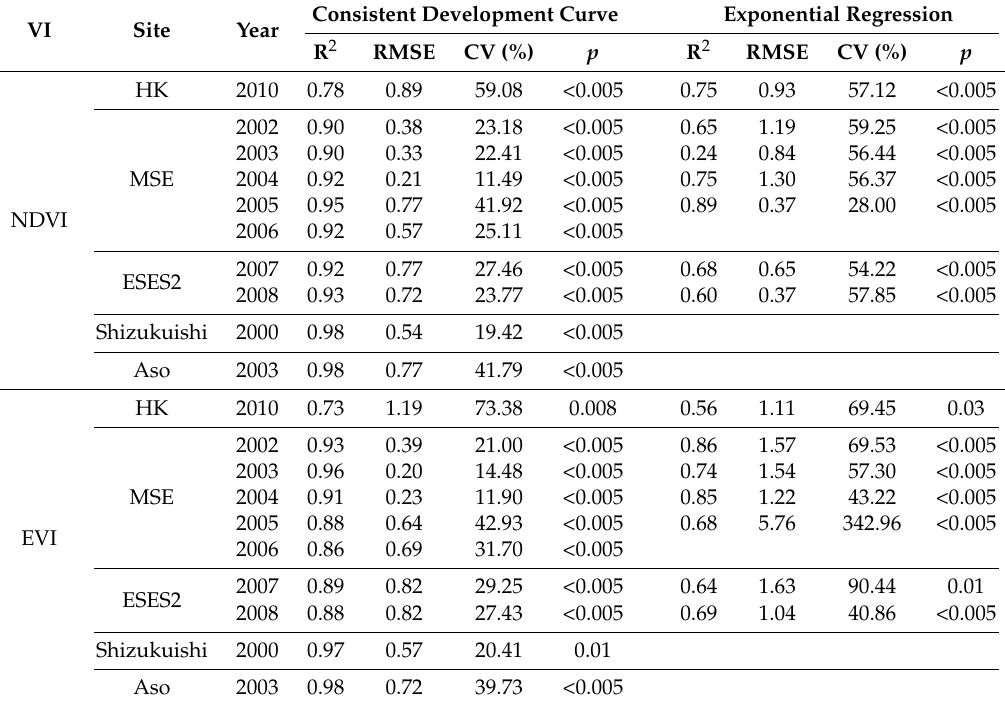
Figure 9. Validation of the consistent development curve method in estimating LAI by applying to an independent dataset from MSE, 2006, Shizukuishi, 2000, and Aso, 2003 in Japan). Table 3. Statistics of the correlation between the measured and the estimated LAI. Estimates of LAI were calculated from consistent development curve method (Figure 7) and exponential regression method (Figure 4). R 2 is the adjusted coefficient of determination, RMSE is the root mean square error, and CV is coefficient of variation of RMSE. HK = Haean (S. Korea), MSE = Mase (Japan), and ESES2 = El Saler-Sueca